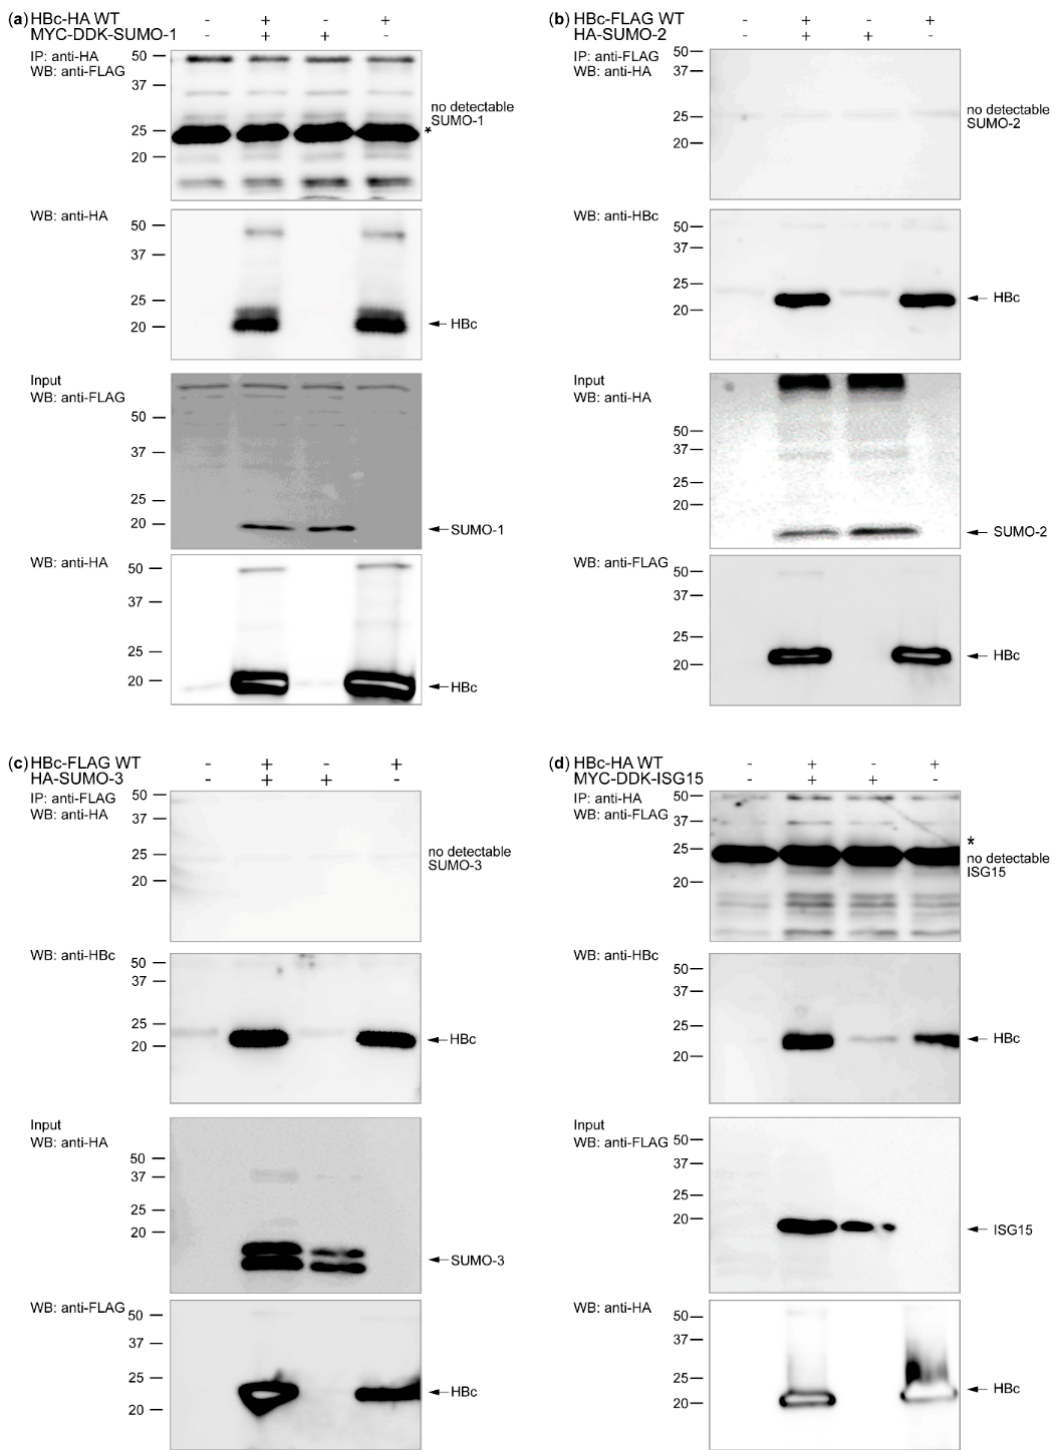
Figure 1. HBc is not post-translationally modified by UBL proteins SUMO 1–3 and ISG15. Western blots of immunoprecipitated cell lysates with anti-FLAG or anti-HA magnetic beads after transient co-transfection of Huh7 cells with HBc and the UBL proteins SUMO-1 ( a ), SUMO-2 ( b ), SUMO-3 ( c ), and ISG15 ( d ). The cells were harvested 48 h post-transfection and precleared cell lysates (1 mg of proteins, WB: Input 10 µg of total protein/lane) were immunoprecipitated with anti-FLAG, or anti-HA magnetic beads. HBc was detected using rabbit polyclonal and tags antibodies. The position of IgG light chains is indicated by *.